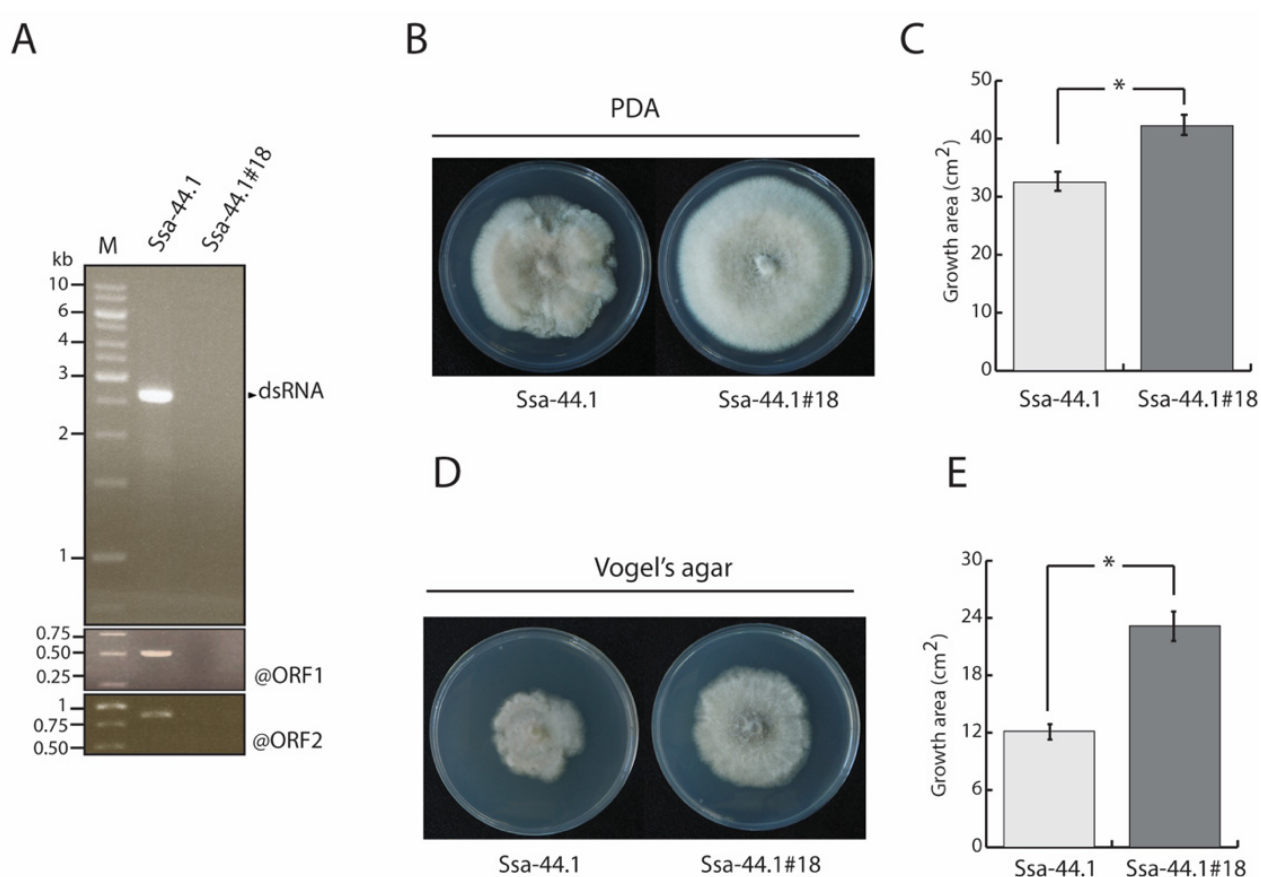
Figure 3. CgRV2’s dsRNA elimination and biological comparison between virus-infected and isogenic virus-free strains. ( A ) Confirmation of the presence of double-stranded RNA between virus-infected CgRV2 and isogenic virus-free strain Ssa-44.1#18 using 1% gel electrophoresis and RT-PCR methods with primers generated from ORF 1 and 2 of CgRV2 sequence. Lane M, marker (GeneRuler 1 kb DNA Ladder). ( B – E ) Colony morphology ( B , D ) and growth area ( C , E ) of fungi when grown at 25 °C on PDA ( B , C ) and Vogel’s agar ( D , E ) for 5 days. The bars indicate standard deviation from five replicates and asterisks indicate that there was significant difference at p < 0.05 using one-way ANOVA analysis ( C , E ). Table 1. Effect of CgRV2 on sporulation level of C. gloeosporioides . Strains